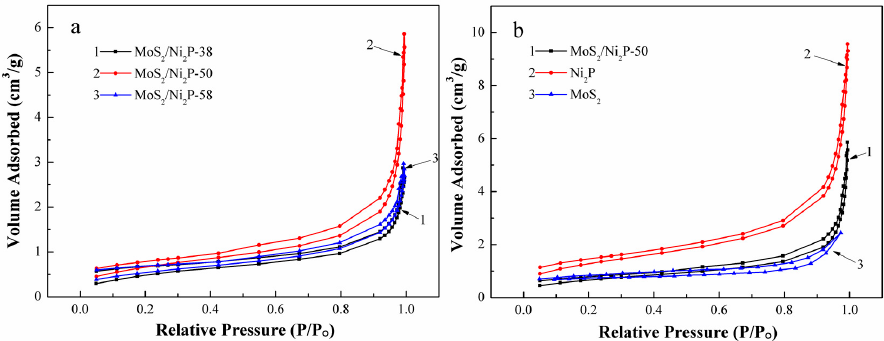
Figure 4. N 2 adsorption/desorption curves of the samples: ( a ) MoS 2 /Ni 2 P-38, MoS 2 /Ni 2 P-50, and MoS 2 /Ni 2 P-58; ( b ) MoS 2 /Ni 2 P-50, Ni 2 P, and MoS 2 .